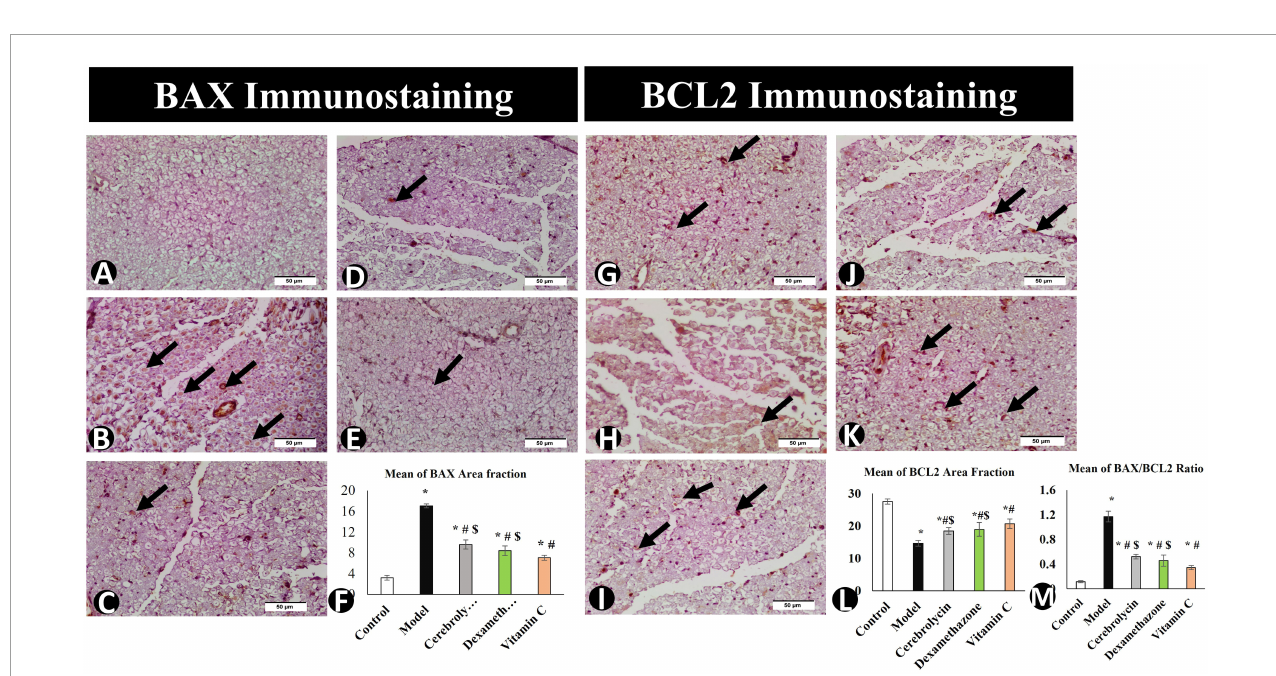
FIGURE8 BAX immunostaining in the control group (A) , the model group (B) , the Cerebrolysin group (C) , the dexamethasone group (D) , and the vitamin C group (E) . (F) Comparison of the expression between different groups. BAX expression was significantly decreased in the model group as compared to the control group. The Cerebrolysin group, dexamethasone group, and vitamin C cause a significant increase in BAX expression correlated with the model group. There was no significant difference between Cerebrolysin and dexamethasone. BCL2 immunostaining in the control group (G) , the model group (H) , the Cerebrolysin group (I) , the dexamethasone group (J) , and vitamin C (K) . Arrows point to positively stained cells. (L) Comparison of the expression between different groups. BCL2 expression was significantly decreased in the model group as compared to the control group. The Cerebrolysin group, the dexamethasone group, and the vitamin C group cause a significant increase in BCL2 expression correlated with the model group. (M) Bax/Bcl2 ratio increased significantly ( P < 0.005) in the model as compared to the control group. Dexamethasone, Cerebrolysin, and vitamin C significantly reduced the Bax/Bcl2 ratio compared to the model group ( P < 0.005). *Significance as compared to control, # significance as compared to model, and $ significance as compared to Vit C